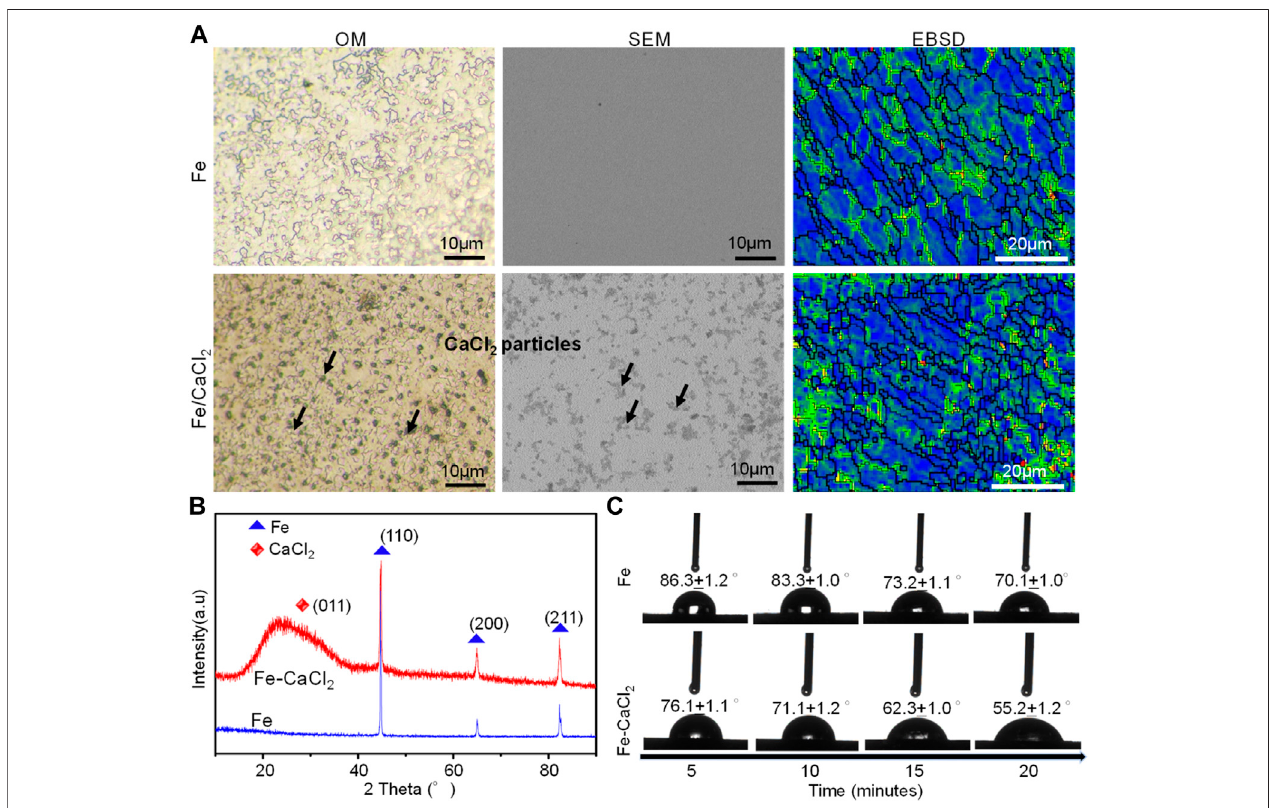
FIGURE 2 | (A) The microstructure, (B) the XRD spectrum, and (C) dynamic results of the hydrophilic angle